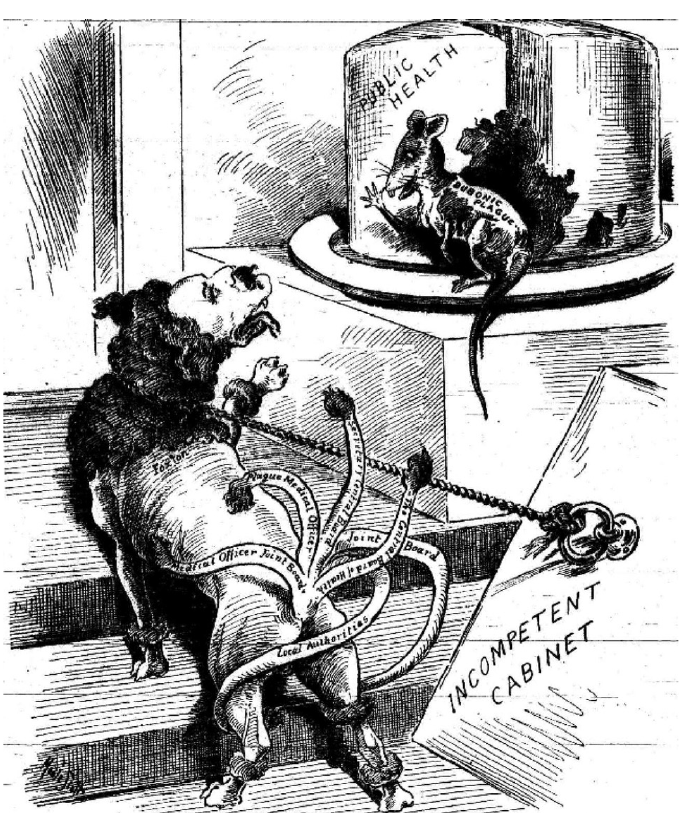
Figure 1. An early example of a personification of the rat as plague, from the Australian paper Worker , 12 May 1900, in an article entitled ‘The Government and the Plague’ (p.